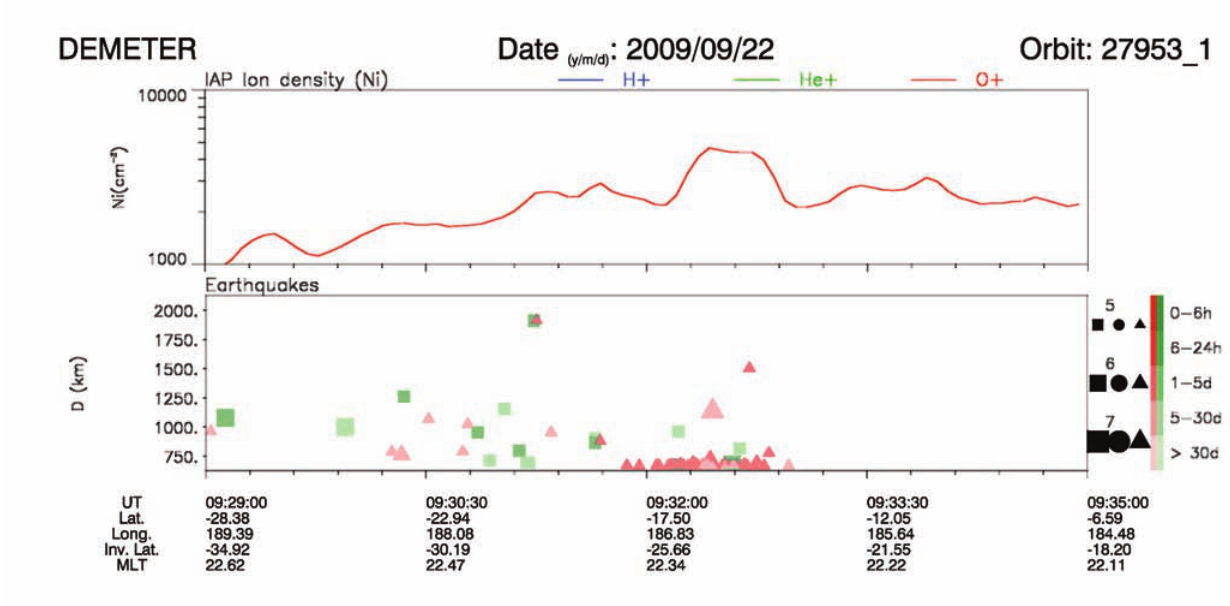
Figure 1. Data recorded on September 22, 2010, between 09.29.00 UT and 09.35.00 UT, 7 days before a powerful earthquake in the Samoa Islands. Top panel, ion density, where due to the scale, only the density of O + ions is seen, as the majority. Bottom panel, distance and magnitudes of forthcoming earthquakes, as a function of time. Red triangles, future main shocks and aftershocks; green symbols, past earthquakes (see text for details). Below the panels, details of the observations (during night-time along the rupture zone of the